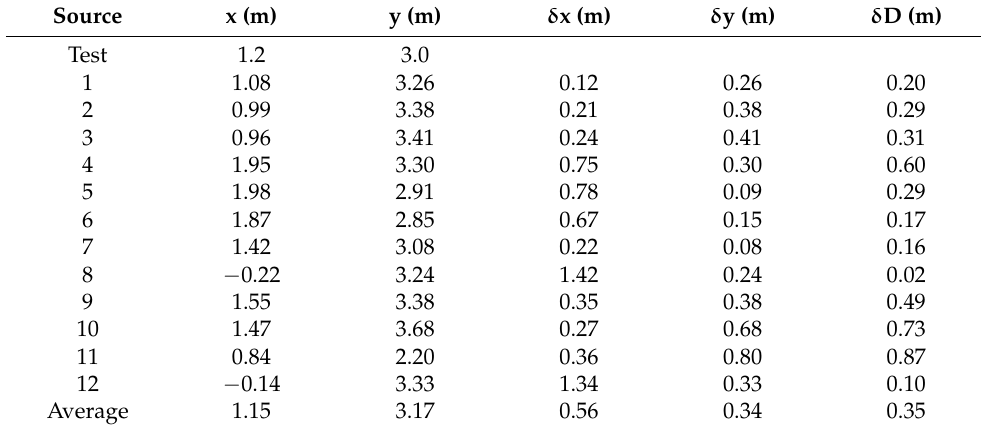
Table 2. 2D localization results with a rectangular